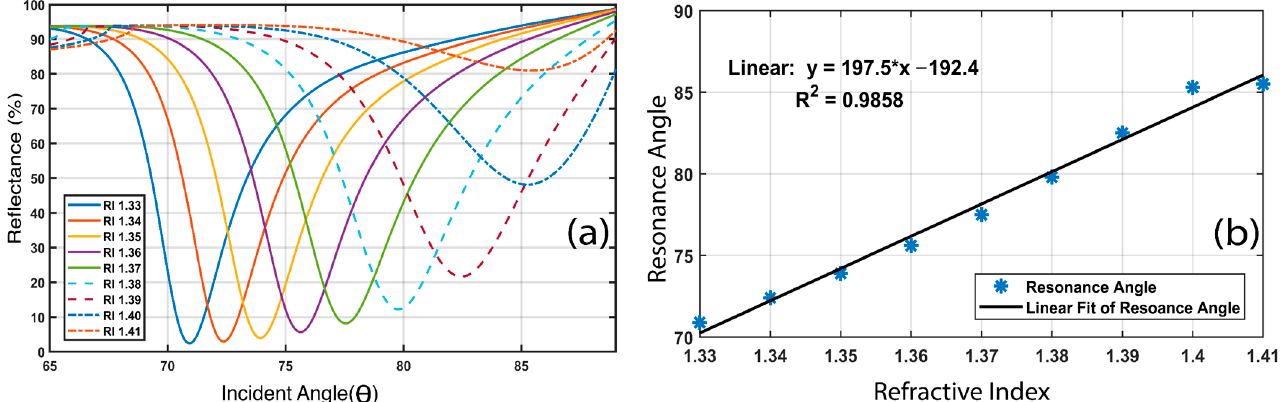
Figure 11. ( a ) The effect of variations in the sensing medium refractive index (RI) on reflectivity and resonance angle for the proposed sensor. ( b ) Resonance angle shift concerning sensing medium refractive index increments and the linear curve fitting where resonance angle is a function of analyte RI.